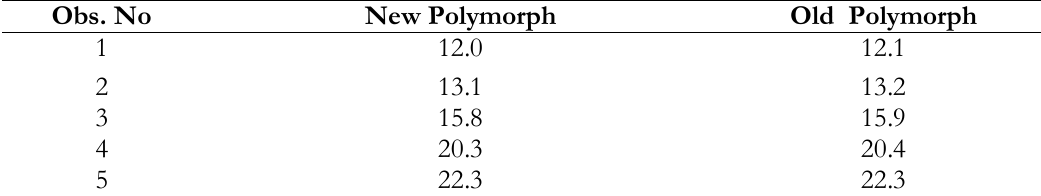
Table I. XRD reflections at 2  degrees for old and new polymorphs of desvenlafaxine Obs.